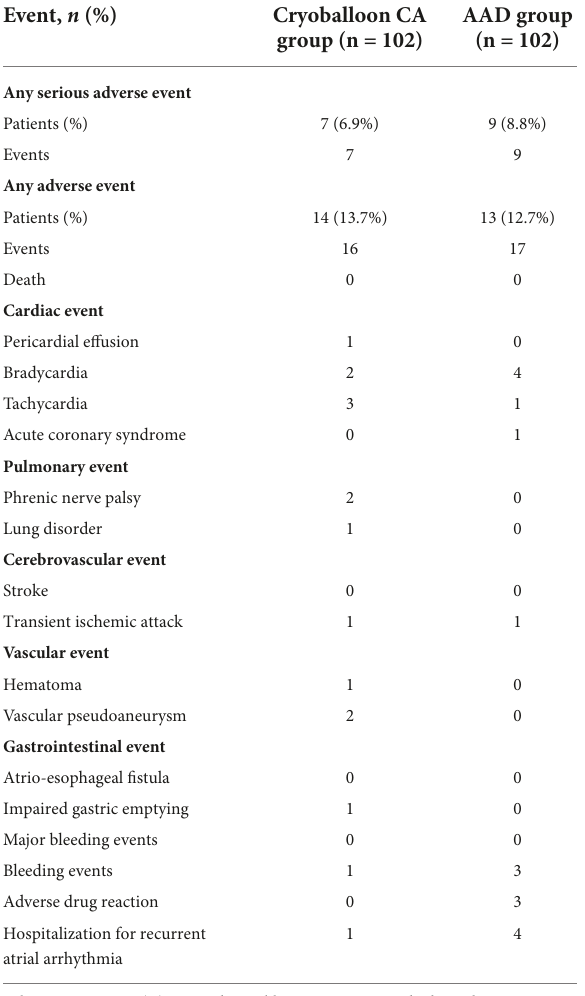
TABLE 4 Adverse